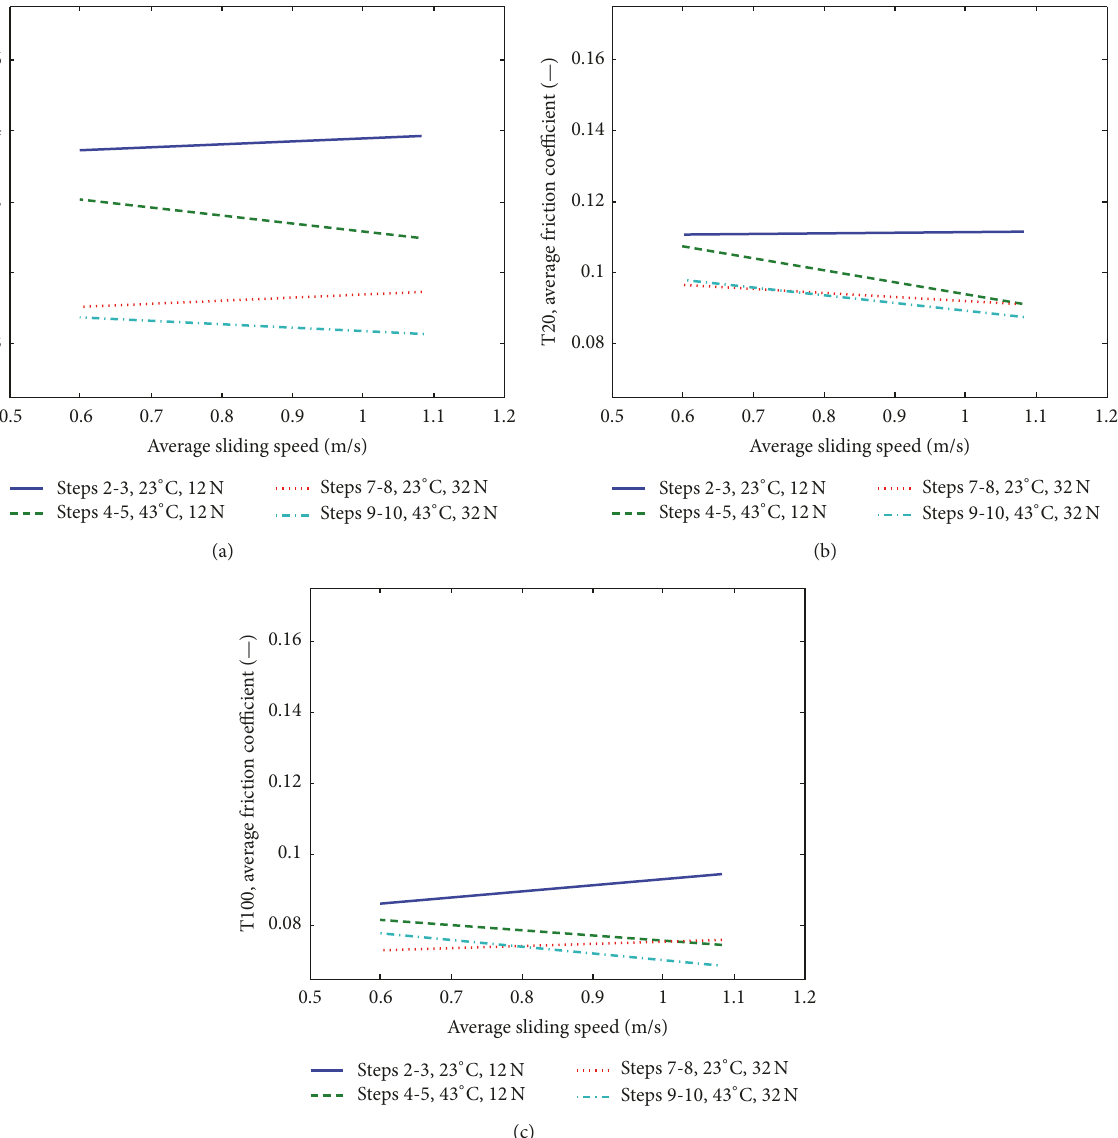
Figure 12: Evaluation of the different levels of DoE input parameters. The effect of sliding speed on the friction coefficient. (a) REF. (b) T20. (c)